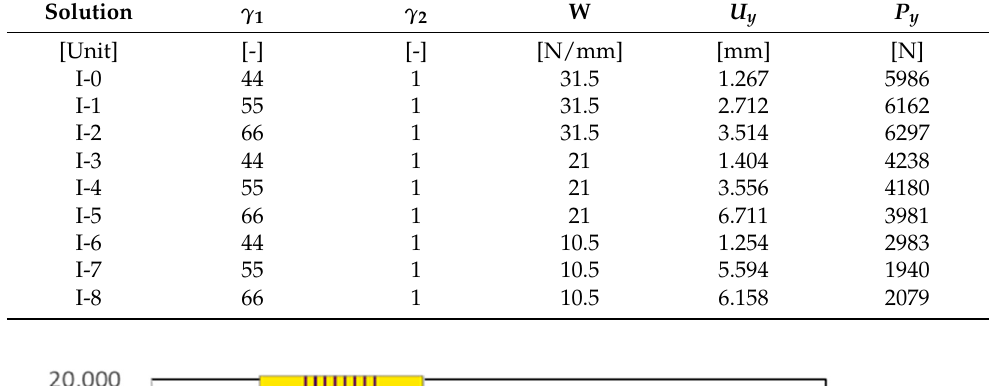
Table 2. Single optimum solutions by strain energy maximization using inverse Fourier formulation (Appendix A).